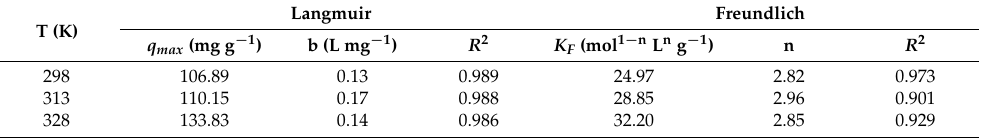
Table 3. The simulated adsorption isotherm parameters of U(VI) on GO15-MIL-101(Fe) composite.